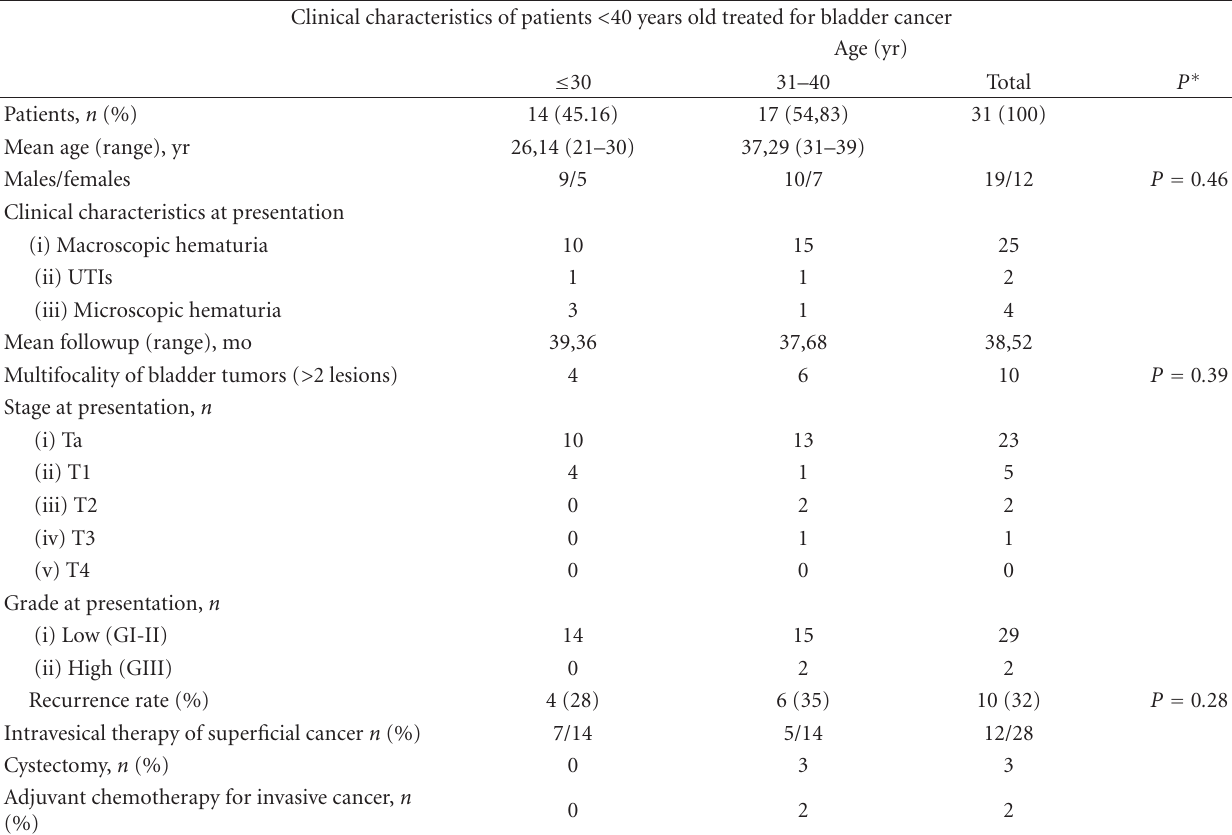
Table 1: Presentation, clinical characteristics, and treatment modalities of young patients with bladder cancer. Clinical characteristics of patients < 40 years old treated for bladder cancer